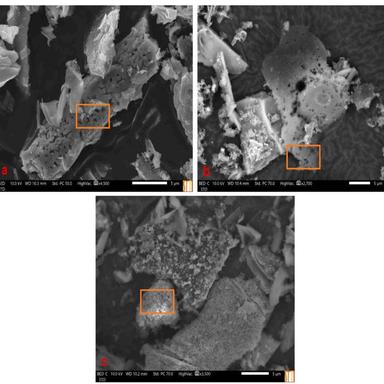
Scanning electron microscopy (SEM) of SCB (a), CS (b), and RH (c) silica.